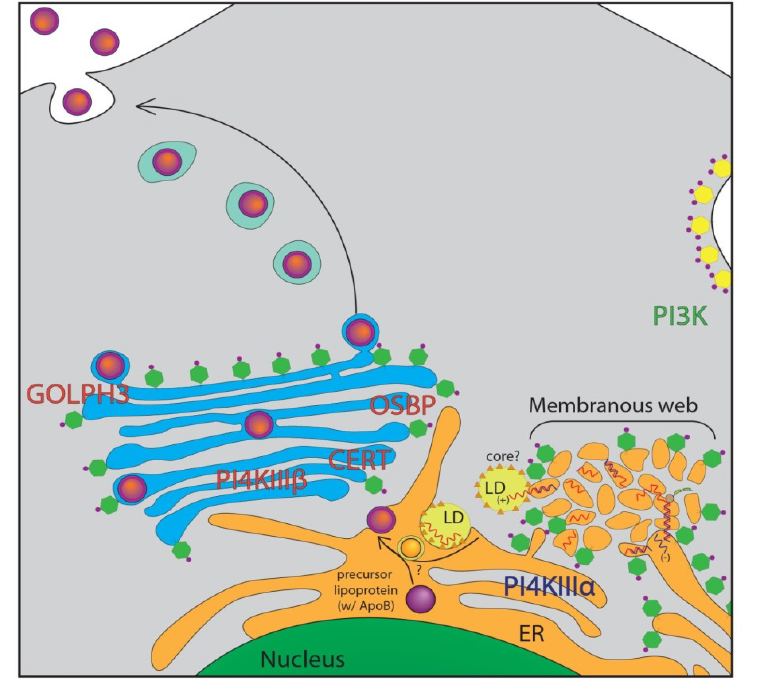
Figure 3. HCV Infected Cellular Distribution of PIPs, Binding Proteins. Diagram of HCV-infected cell showing enrichment of PI4P at the ER and membranous web, with model of potential HCV assembly pathway in conjunction with lipid droplets (LDs) and ApoB precursor lipoprotein [7]. HCV RNA is produced in replication complexes at membranous web structures juxtaposed to ER, and in close association with LDs. Viral assembly site is unknown, but viral particles may associate with ApoB precursor lipoproteins. Infectious viral particles are then likely trafficked through the Golgi and released at the PM. PIP associated proteins known to affect the HCV lifecycle are highlighted. Akt pathway-PI3K (green text). Replication- PI4KIIIα (blue text). Secretion- PI4KIIIβ, OSBP, CERT, GOLPH3 (red